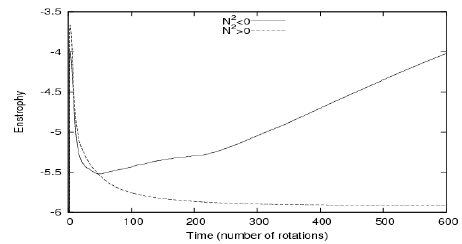
Figure 2. Evolution of the enstrophy for a stable and an unstable stratification.